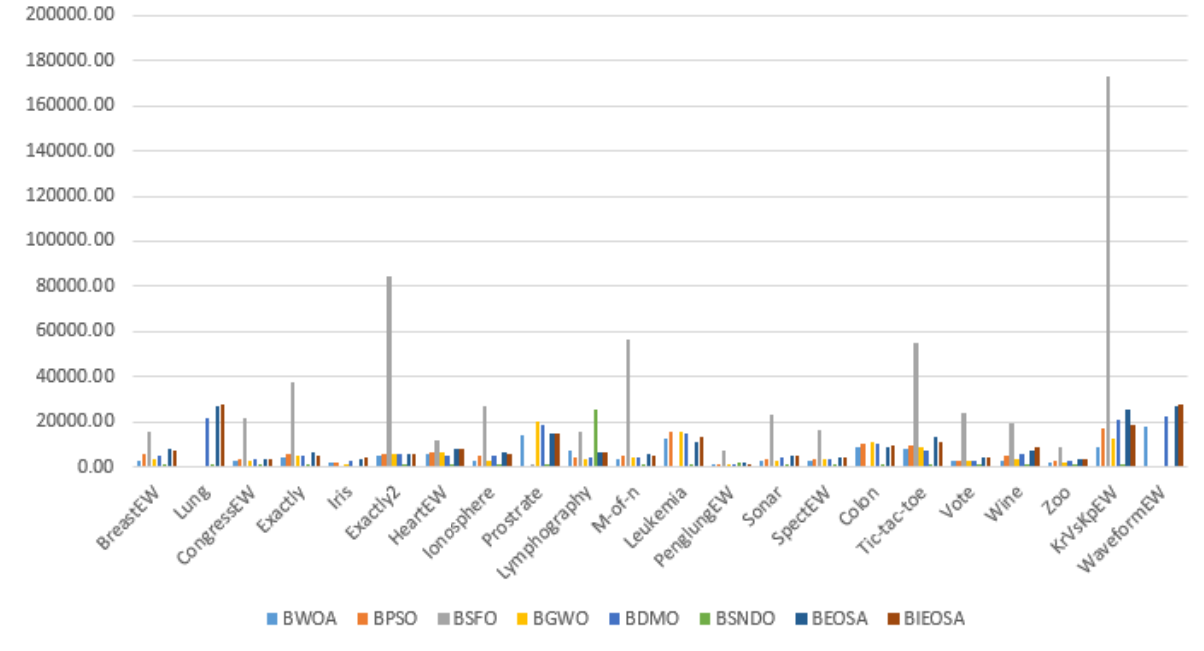
Figure 10. Comparison of the computational times for BWOA, BPSO, BSFO, BGWO, BDMO, BSNDO, BEOSA and BIEOSA on all the benchmark datasets.